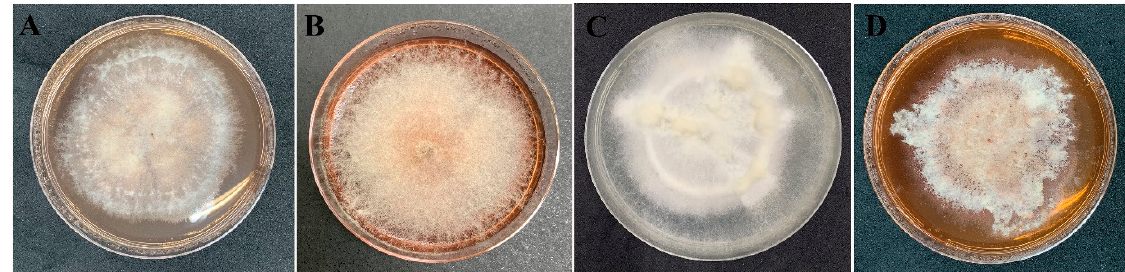
Figure 4. Morphology characteristic of endophytic fungi on PDA medium after 2 weeks. Neocosmospora sp. ( A ) MFLUCC 17-0251, ( B ) MFLUCC 17-0253, ( C ) MFLUCC 17-0257, and ( D ) MFLUCC 17-0259.